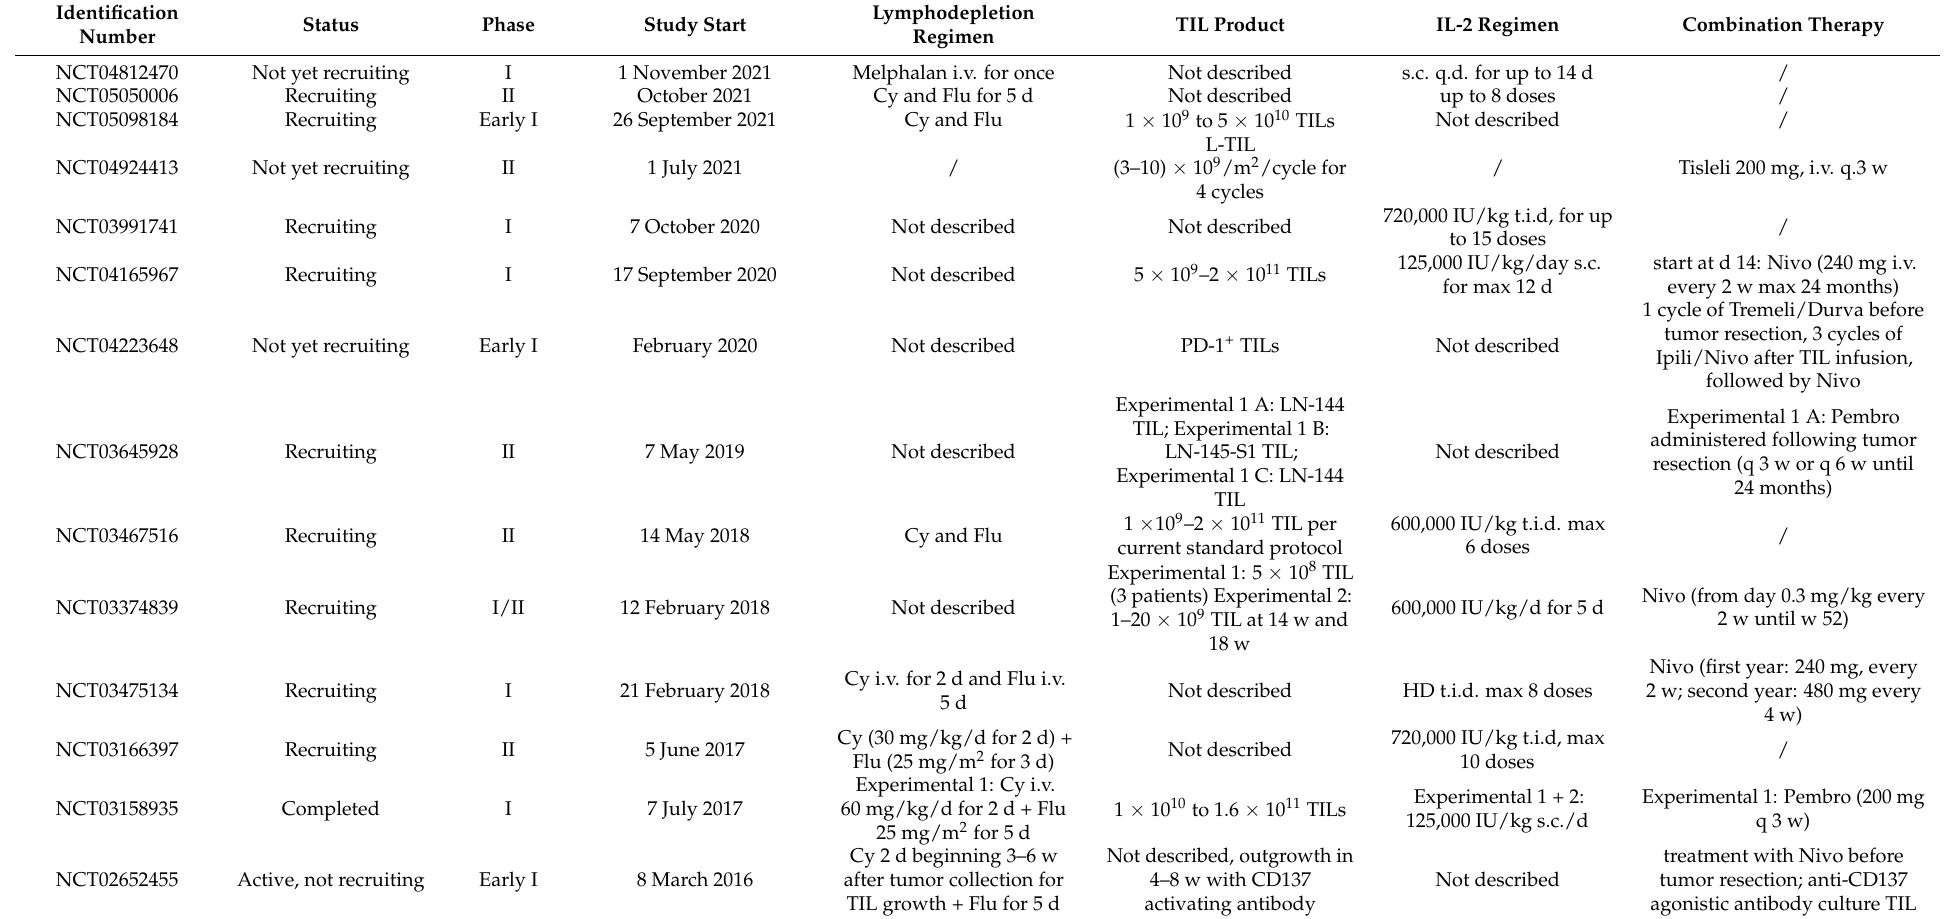
Table 1. Clinical trials with TILs for melanoma from ClinicalTrials.gov between 2011 and